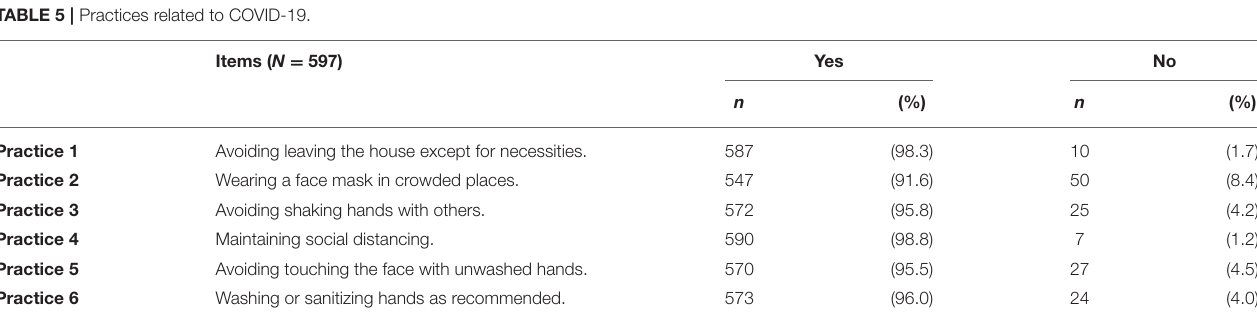
TABLE 5 | Practices related to